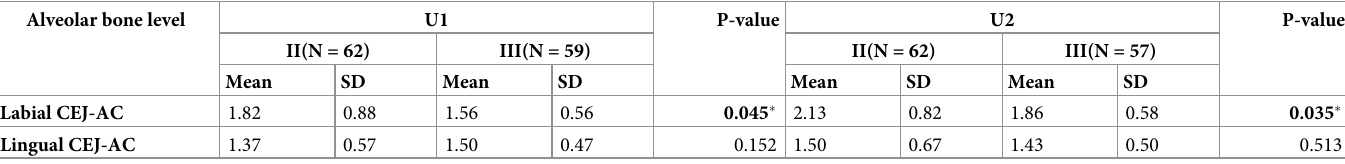
Table 3. Comparison of maxillary anterior vertical bone level between high-angle skeletal Class II malocclusion patients and high-angle skeletal Class III malocclu- sion patients (mm). Alveolar bone level